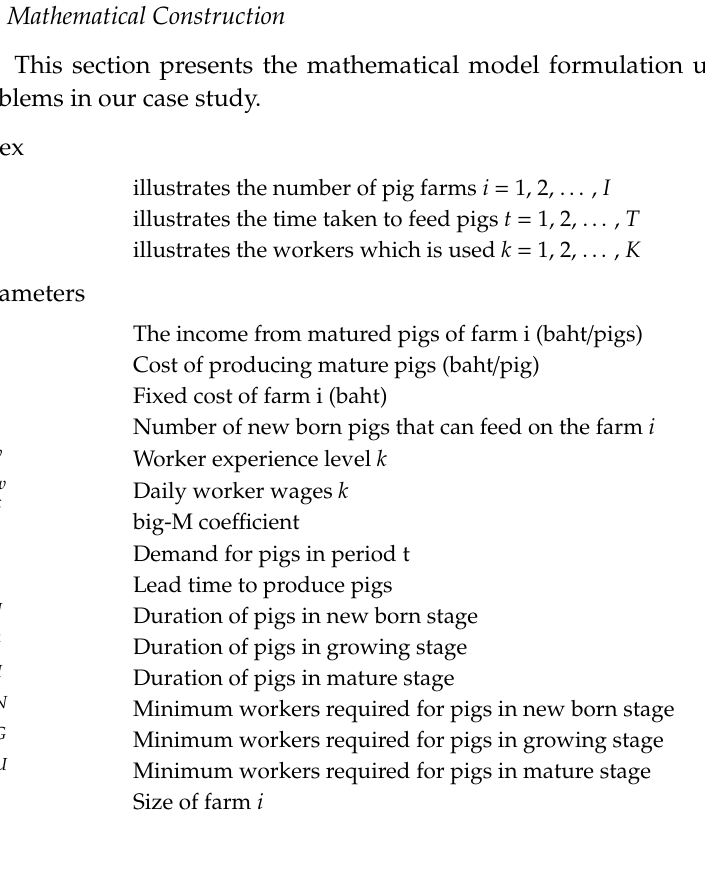
Figure 1. Pig production plan.